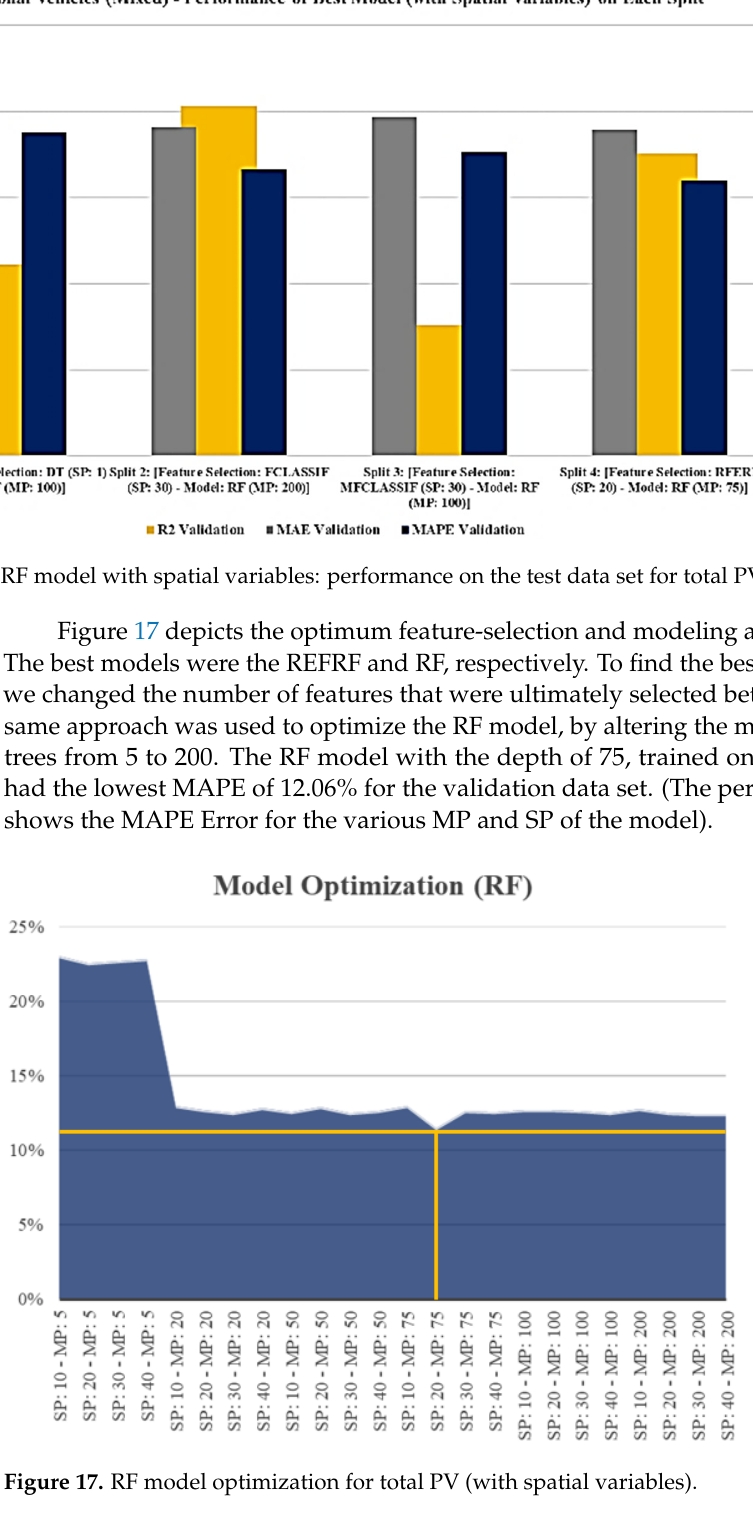
21 Table 6. Comparison of the RF models’ performance for the test data set. Models